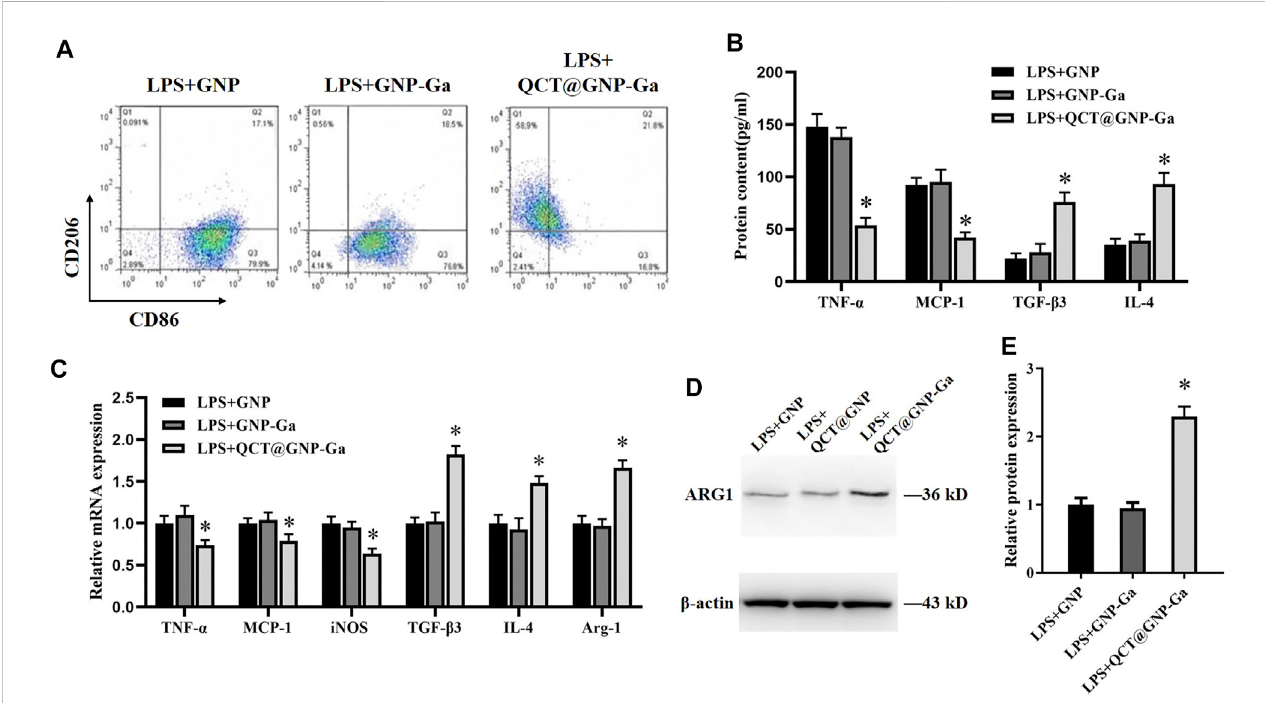
FIGURE 4 Induction of macrophages from M1 to M2 phenotype by QCT@GNP-Ga. (A) Representative images of FCM analysis of LPS induced RAW264.7 cells treated with GNP, GNP-Ga, or QCT@GNP-Ga. (B) EILSA analysis of TNF- α , MCP-1, TGF- β 3, and IL-4 protein expressions in LPS induced RAW264.7 cells treated with GNP, GNP-Ga, or QCT@GNP-Ga. (C) qPCR analysis of TNF- α , MCP-1, iNOS, TGF- β 3, IL-4, Arg-1 mRNA expressions in LPS induced RAW264.7 cells treated with GNP, GNP-Ga, or QCT@GNP-Ga. (D) Western blot analysis and (E) statistical results of ARG1 protein expressions in LPS induced RAW264.7 cells treated with GNP, GNP-Ga, or QCT@GNP-Ga. Data are shown as mean ± SD, * p < 0.05 compared with LPS + GNP